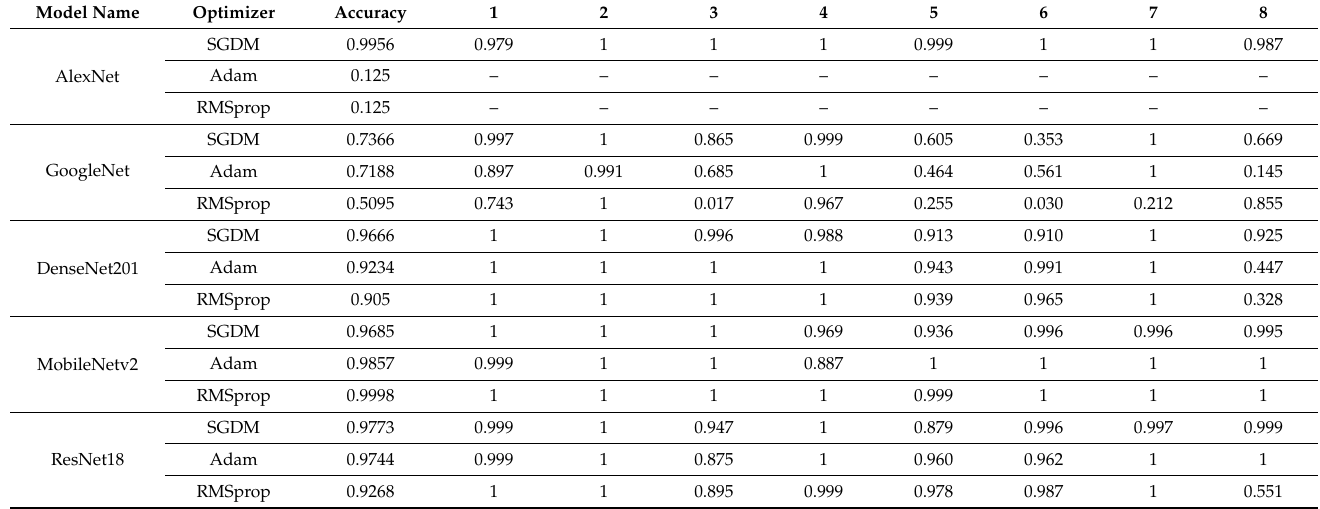
Table 8. COLOR QR Code Per Printer Identification Result for Each Pretrained CNN